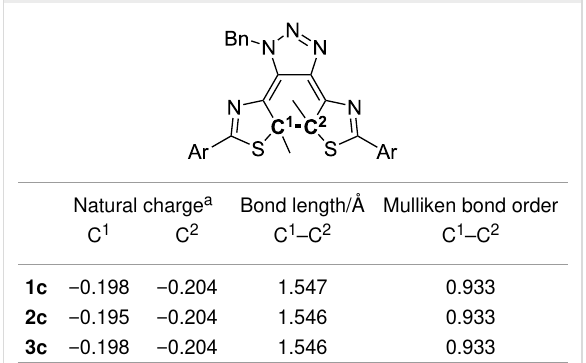
Table 4: Natural charge, bond length and bond order of the bond- breaking carbon atoms of triazoles 1c – 3c in the thermal back reac- tions obtained by DFT